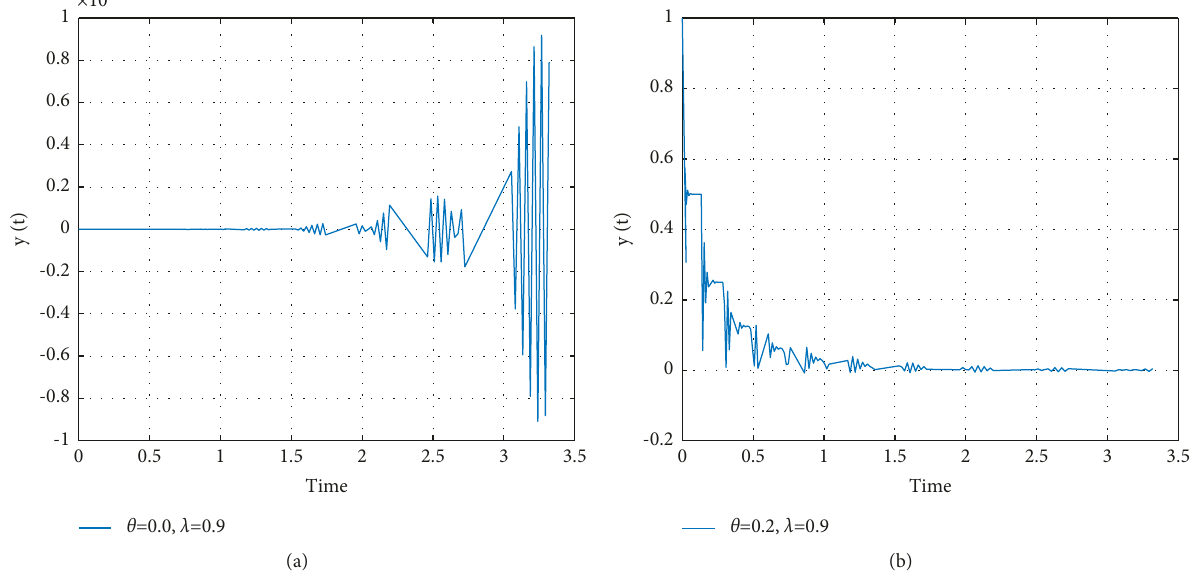
Figure 2: Numerical simulations of model (36) with ϑ � 0 . 0 (a) and ϑ � 0 . 2 (b), when λ � 0 . 9.